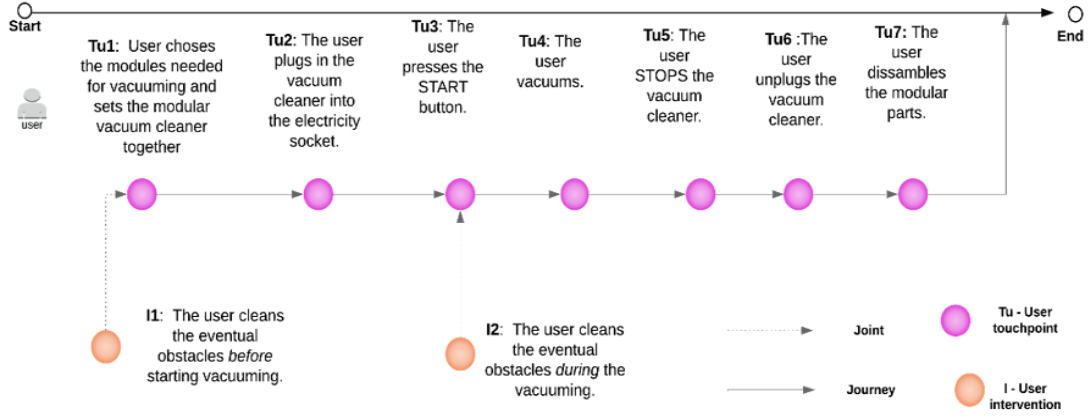
Figure 3. User journey when using an ordinary device (Situation 1).